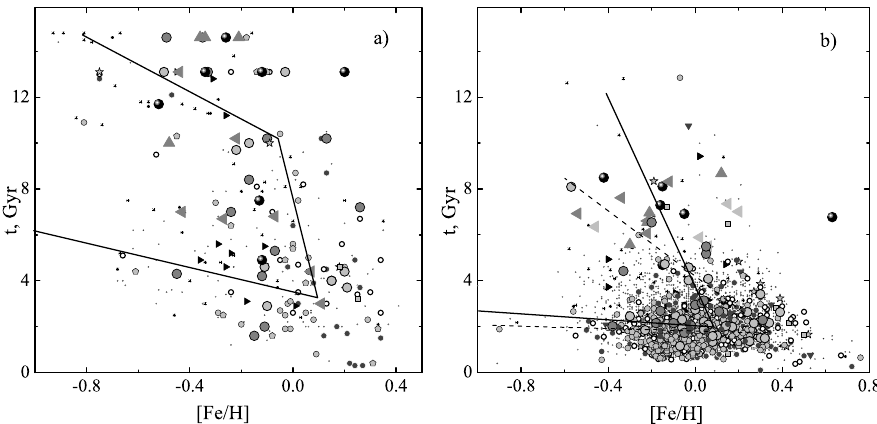
Fig. 3. Age-metallicity relations based on the data from Bensby et al. (2014) (the left-hand panel) and Casagrande et al. (2011) (the right-hand panel). The lower oblique lines in the diagrams reflect approximately the increase of the average age with decreasing metallicity for relatively young thin-disk field stars, and the steeper oblique lines (and line segments) reflect the corresponding increase in age for old stars of the thin and thick disks. The dashed lines represent the two branches of the Hercules stream. The symbols are the same as in Fig.